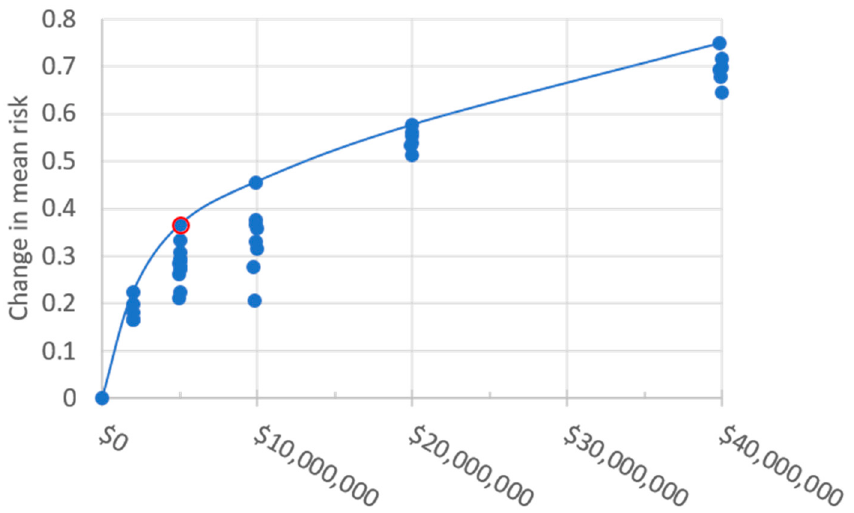
Figure 5. Pareto front based on highest weighted mean risk change for a range of budgets with the selected pareto optimal solution marked by a red circle.